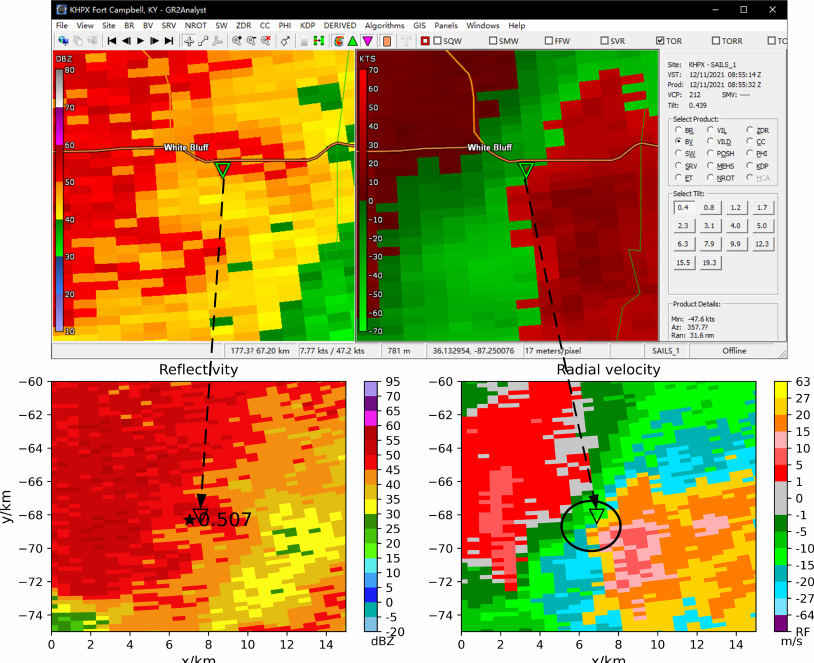
Figure 11. TDA-RF detection results on NEXRAD radar data. KHPX radar 2021-12-11 08:55 (UTC), the tornado was EF2. (The inverted triangle is the warning result of GR2Analyst, and the asterisk and circle are the warning result of TDA-RF).